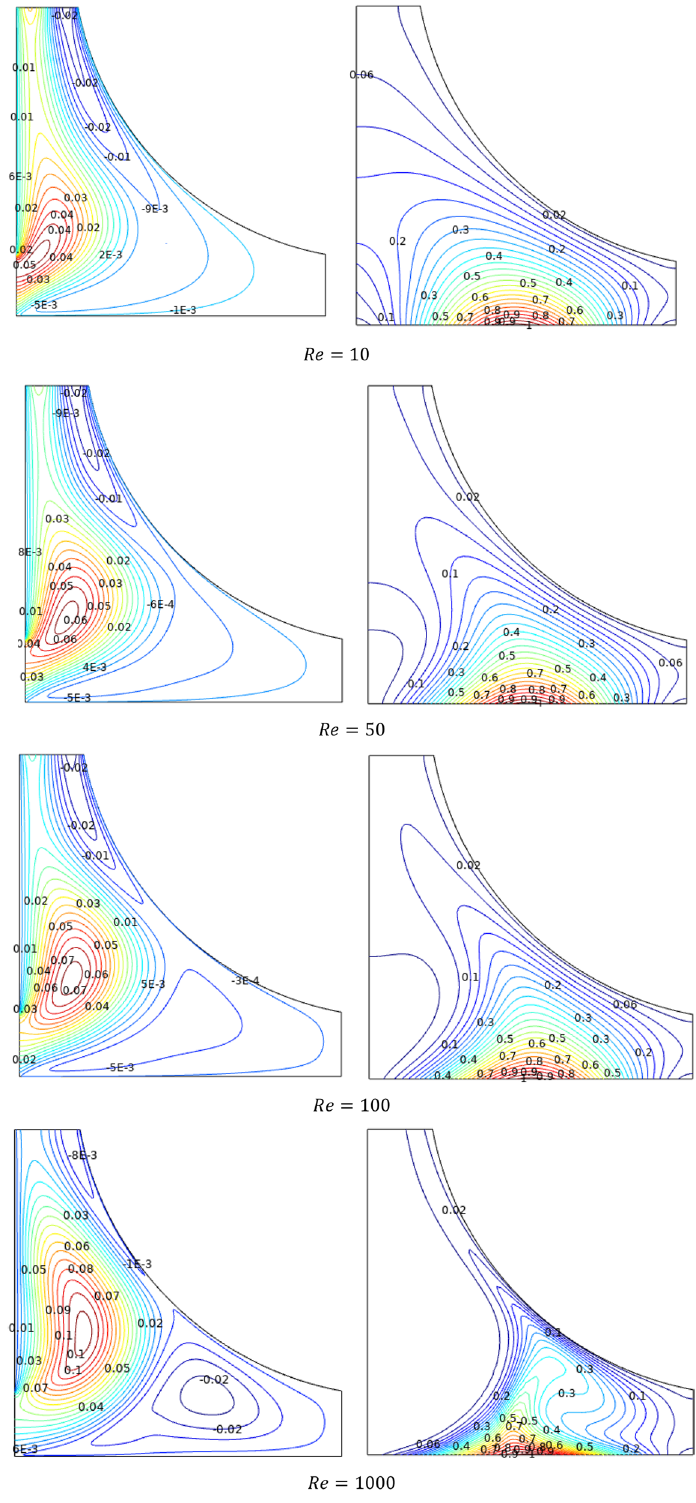
Figure 4. Variations of the streamlines ( (cid:31) ) and isotherms ( T ) with various Reyolds number ( Re ) at configuration 1, Ha = 0 , Ri = 1 , ϕ = 0.02